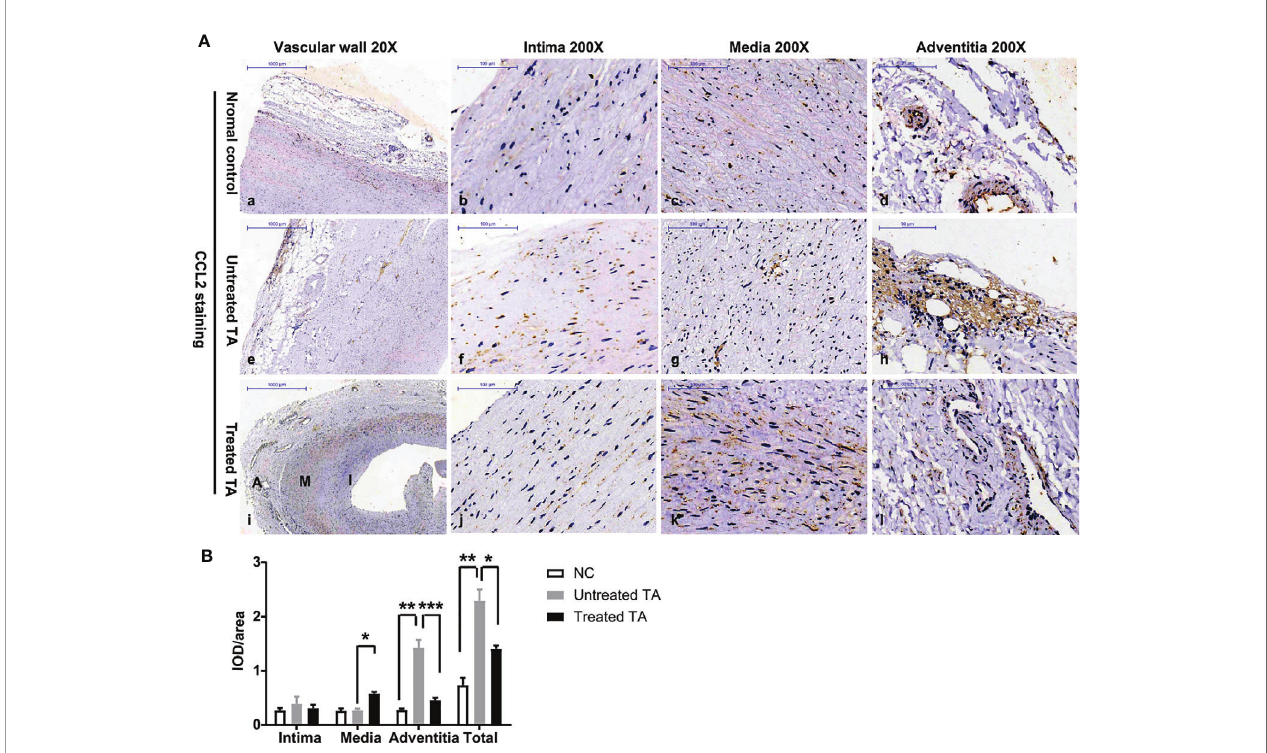
FIGURE 4 | CCL2 expression in arterial specimens from controls, untreated TA, and treated TA (A) Representative immunohistochemistry images of CCL2 in normal aorta (a – d), TA untreated aorta (e – h), and TA treated renal artery (i – l). (B) Quanti fi cation of CCL2 expressions in normal arteries, untreated, and treated TA arteries (intima, media and adventitia). *< 0.05; **< 0.01; ***< 0.001.